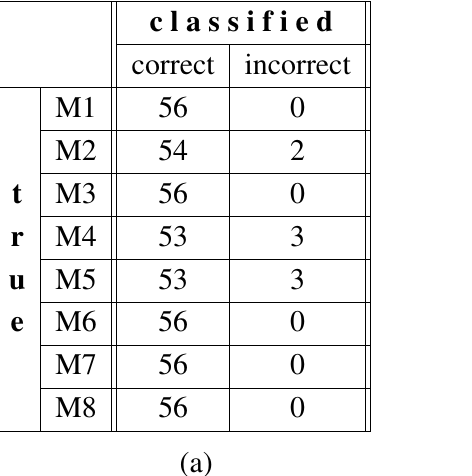
Table 12. (a) Number of correctly and incorrectly classified feature vectors out of 56 for SVMs (LOO cross validation, 98.2%); (b) same for ANN (LOO cross validation,